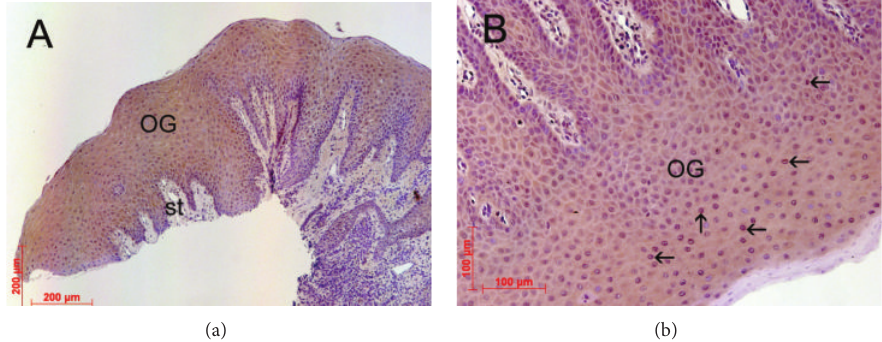
Figure 1: Demonstration of the glycine receptor (GlyR) in gingival tissue. Overview (a) of oral tissue (magnification × 10) isolated from extracted upper third molars showing different region of the gingival tissue (OG: oral gingival tissue; st: subepithelial tissue). (b) Representative gingival tissue section (magnification × 200) assessed by immunohistochemistry using an anti-glycine receptor antibody (SYSY, G¨ottingen, Germany) at 4 ∘ C overnight and counterstaining with DAB (brown color). There was strong immune reaction in the epithelial layers of the gingiva, namely, in gingival keratinocytes. The underlying basal membrane as well as the connective tissue showed negative immune staining.